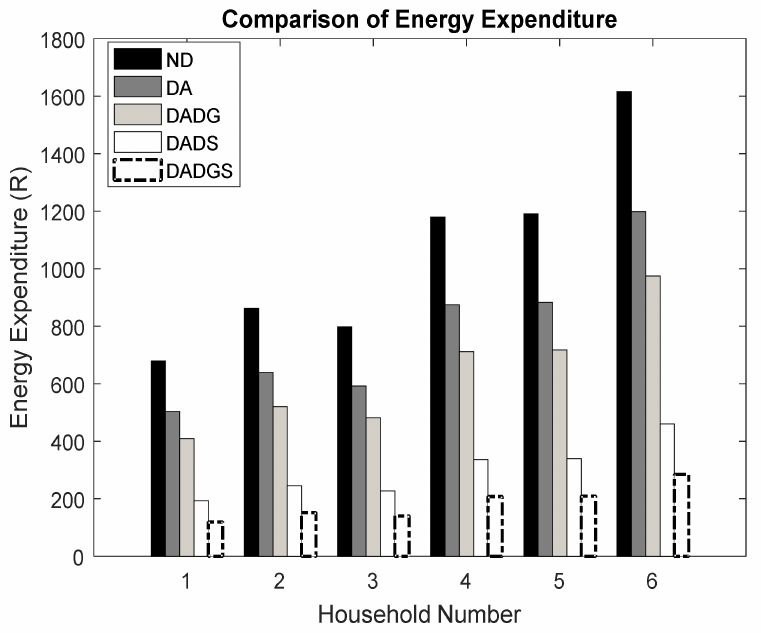
Figure 3. Energy expenditure by